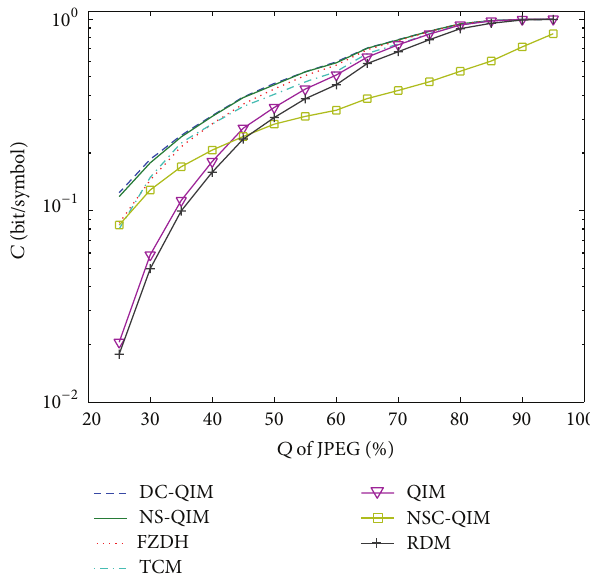
Figure 4: Capacity under AWGN for natural grayscale images.